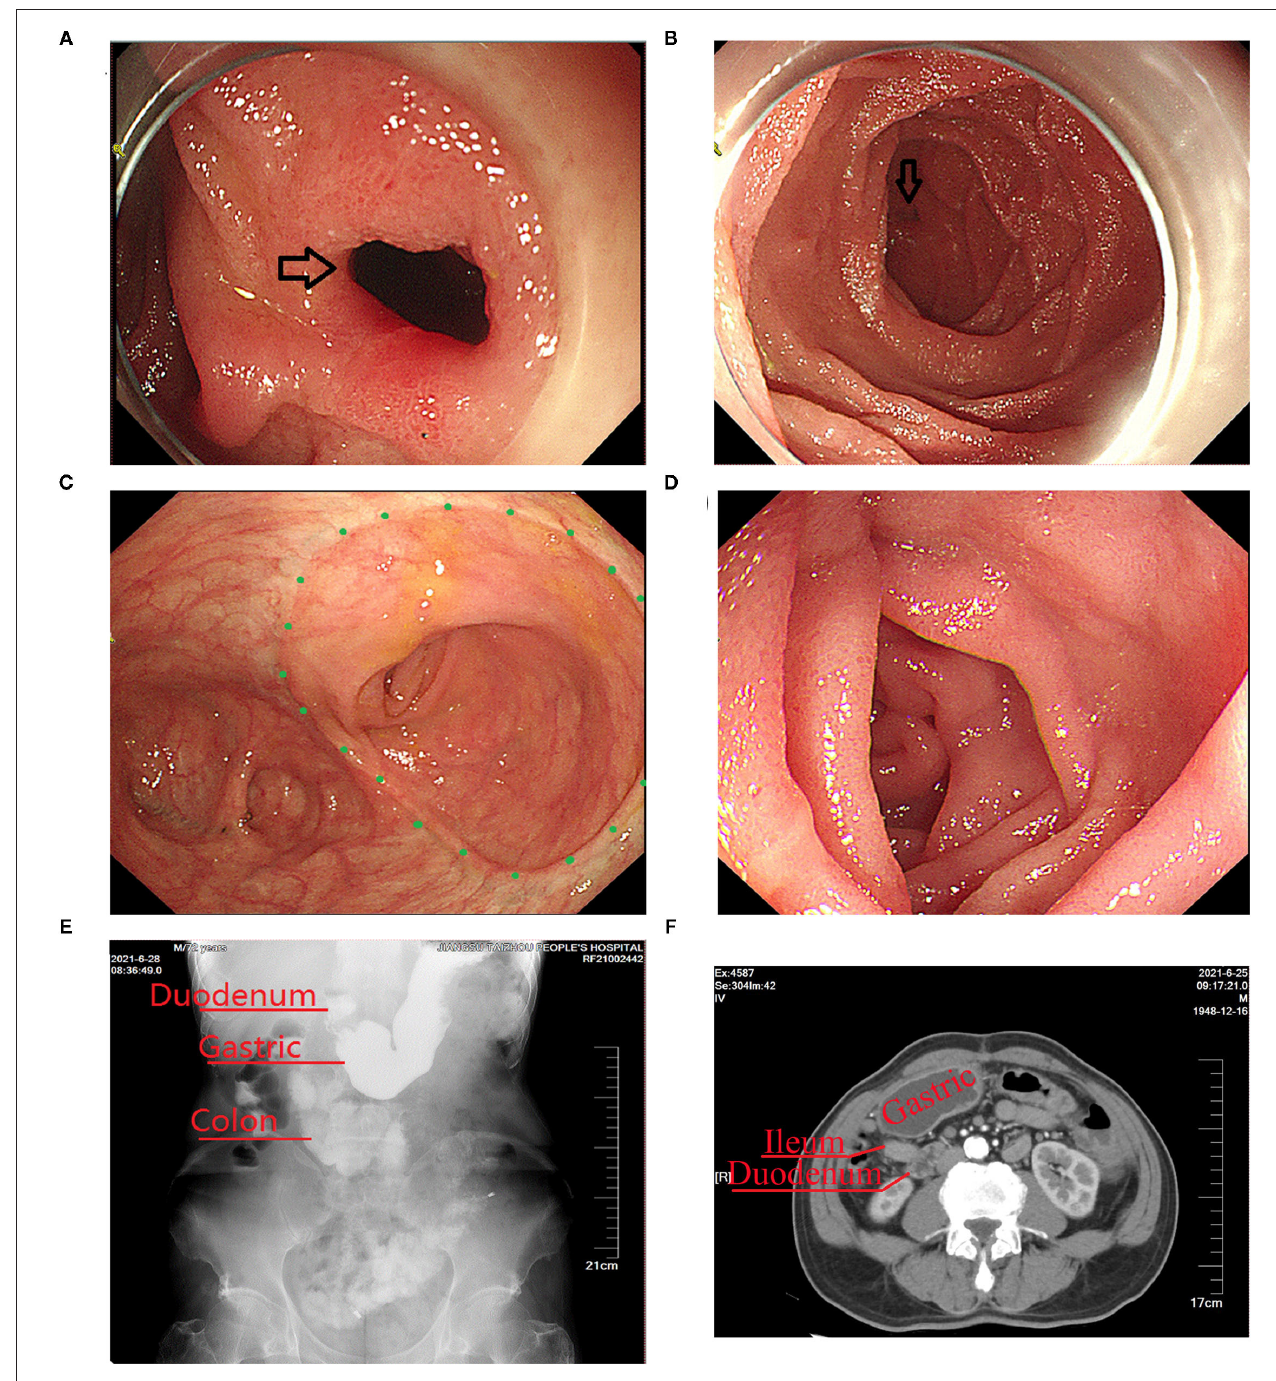
FIGURE 3 | Imaging findings obtained before surgical treatment of the duodeno-distal ileal fistula. (A,B) Gastroscopy showed a fistula in the descending part of the duodenum (the black arrow indicates the fistula). (C) Colonoscopy showed that there were no abnormalities in the ileocolic anastomosis (indicated by the green dot). (D) Colonoscopy showed that there were no abnormalities in the terminal ileum. (E) Upper gastrointestinal imaging examination showed that after passing through the duodenum, the contrast agent directly entered the lower colon. (F) CT scan showed that there was no obvious mass around the anastomosis and no inflammatory